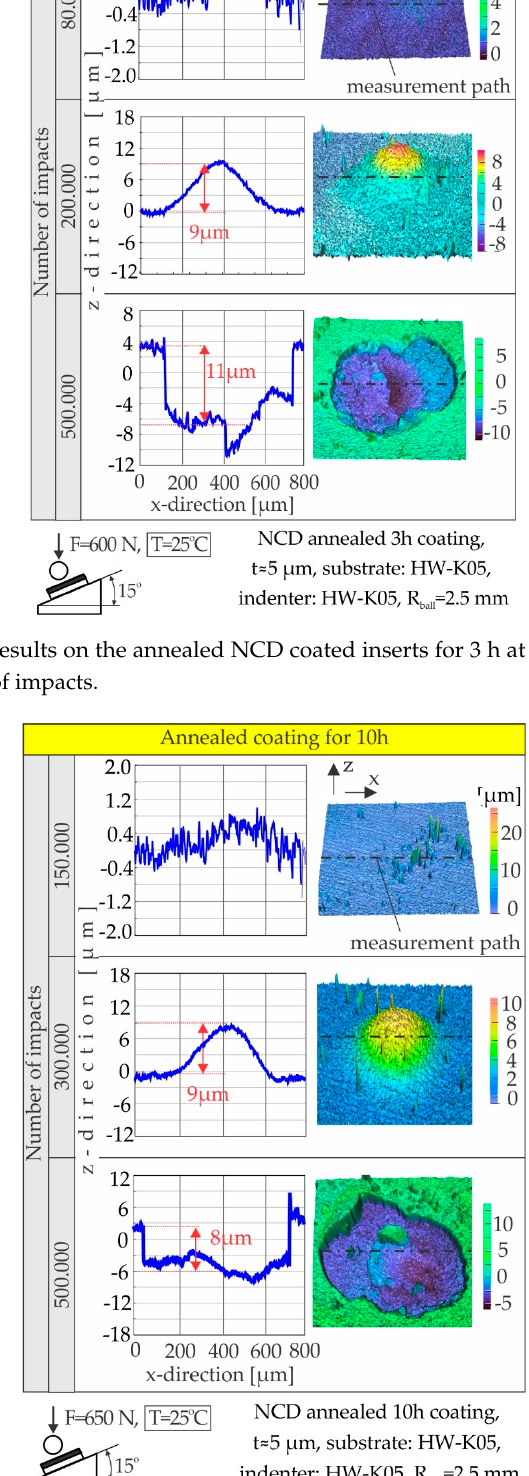
Figure 9. Impact test results on the annealed NCD coated inserts for 10 h at an impact load of 650 N after various number of impacts.